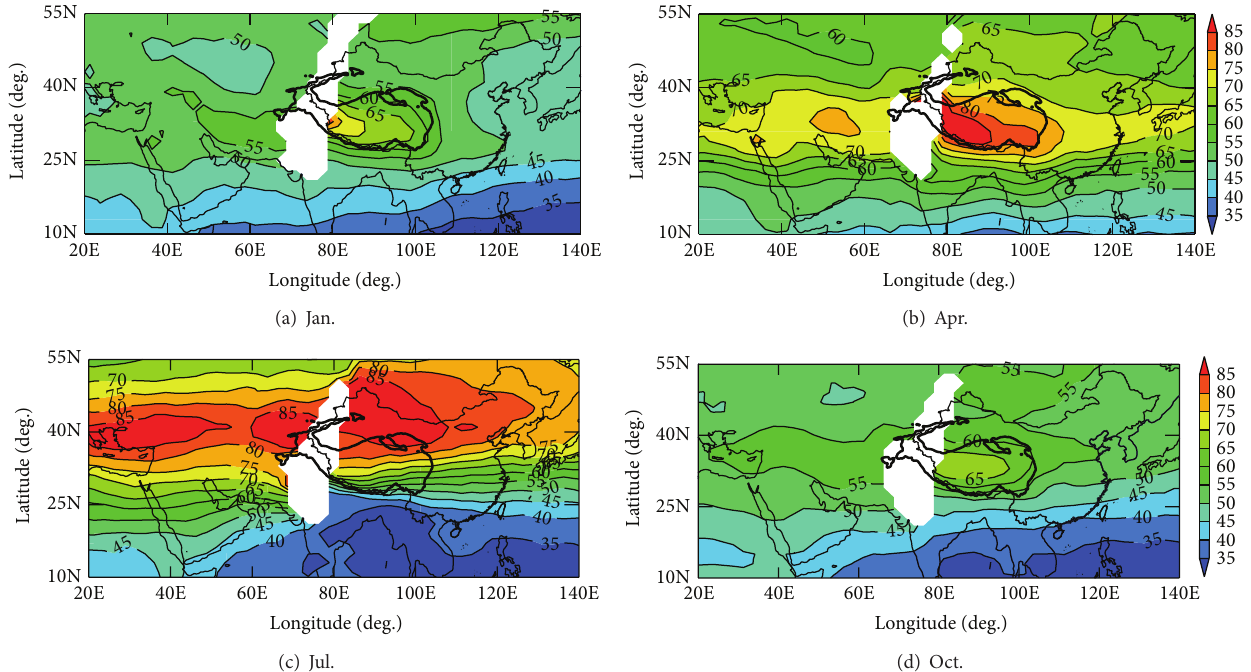
Figure 3: The same as Figure 1, but for tropospheric ozone volume mixing ratio (TOVMR, unit: ppbv).